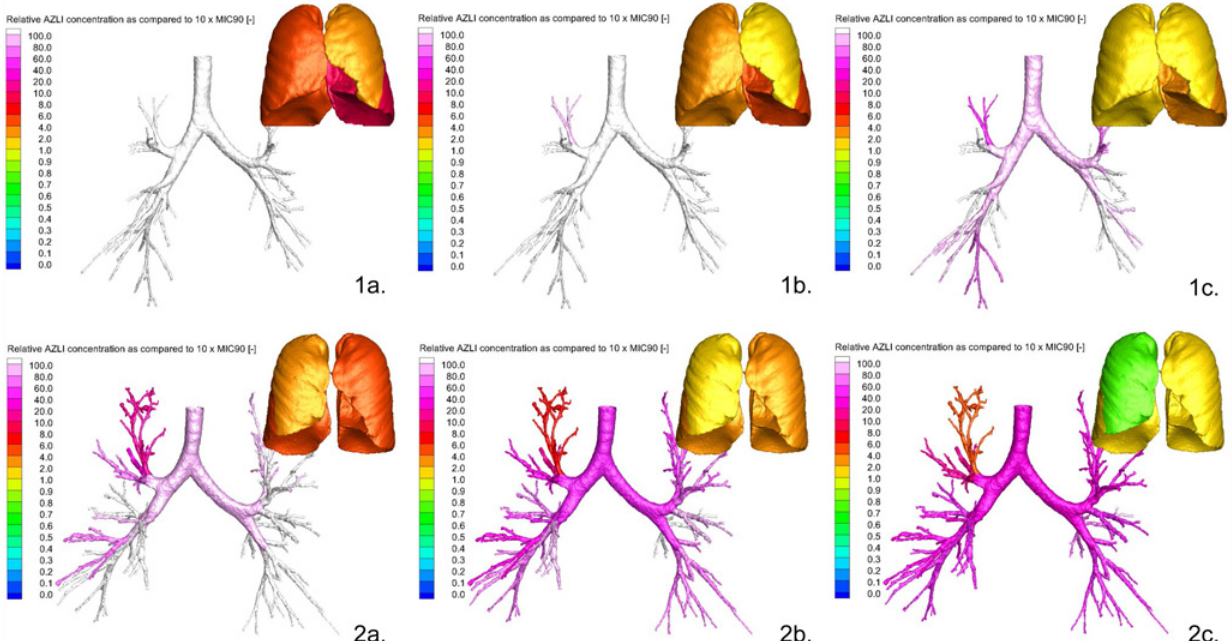
Fig 5. Relative AZLI concentrations in central and small airways of 2 patients for 3 different scenarios. Simulations of AZLI deposition in 2 patients, representing 3 scenarios of varied airway surface liquid thickness (ASL) and aerosol diameter. Severity of CF lung disease was determined by the CF-CT score (% of total CF-CT score). Scenario a = thin ASL with smallest aerosol diameter; scenario b = median ASL with median aerosol diameter; scenario c = thick ASL with largest aerosol diameter. Part 1a, 1b and 1c: Patient 1, mild CF lung disease: bronchiectasis 0.0%, airway wall thickening 0.0% and air trapping 11.1%. Patient 1 received concentrations > 10xMIC 90 in the central and small airways independent of ASL thickness and aerosol diameter (Part 1a, 1b, 1c). Part 2a, 2c and 2c: Patient 2, more severe lung disease: bronchiectasis 12.5%, airway wall thickening 11.1% and air trapping 38.9%. Patient 2 received concentrations > 10xMIC 90 in the central and small airways in scenario a and b (Part 2a and 2b), but AZLI concentrations < 10xMIC 90 in the small airways in scenario c (right upper and middle lobes) (Part 2c).